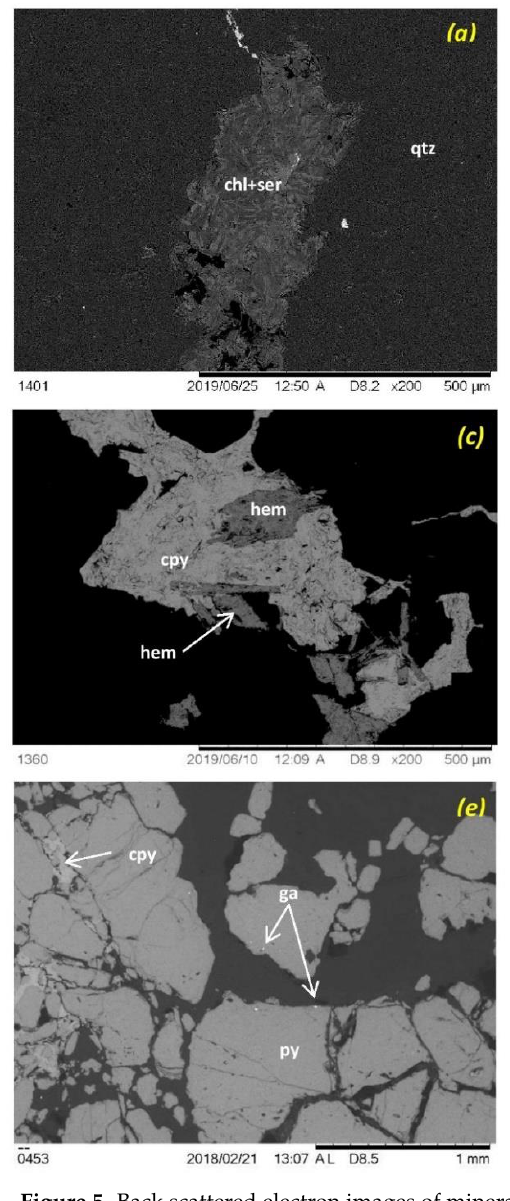
Figure 5. Back scattered electron images of mineral assemblages from Assarel. ( a ) Chlorite (dark gray) and sericite (gray) intergrowths in the vugg (CPH assemblage, sample AS21). ( b ) Pyrite surrounded by chalcopyrite in a rock with sericitic-chloritic alteration (CPH assemblage, sample AS18). ( c ) Euhedral hematite (dark gray) replaced and overgrown by chalcopyrite (light gray) in a rock with sericitic-chloritic alteration (CPH assemblage, sample AS21). ( d ) Fine pyrite (white grains) disseminated in rock with argillic alteration (PC assemblage, sample AS4). ( e ) Aggregate of coarse pyrite grains in quartz-pyrite assemblage. Galena inclusions (white dots) occur in the peripheral zone of pyrite grains (QP assemblage, sample AS3). ( f ) Supergene alteration of pyrite (gray), by substitution with chalcocite (light grey),